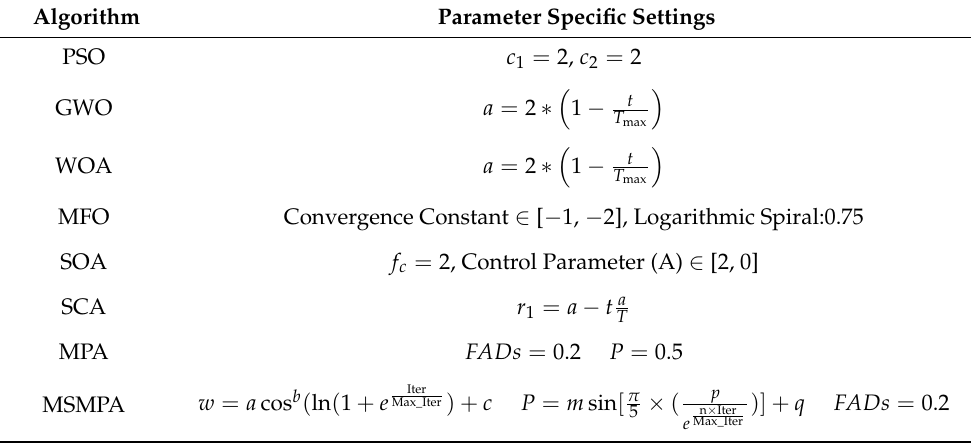
Table 1. Parameter settings for each algorithm.